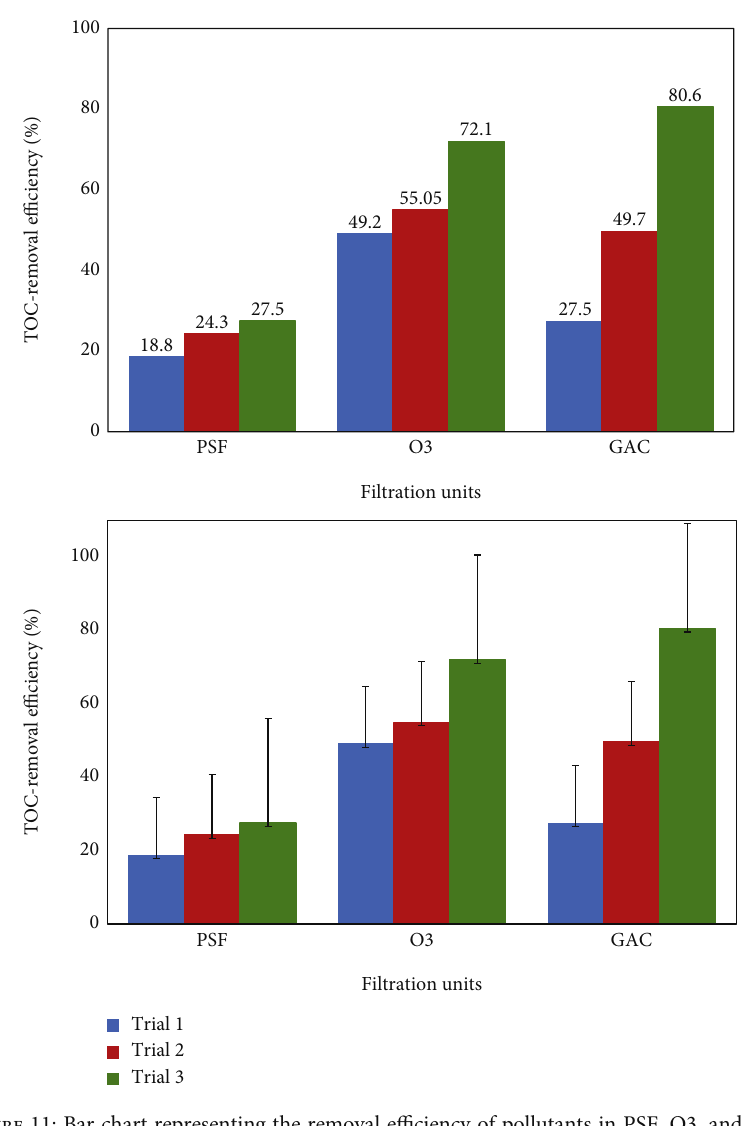
Figure 11: Bar chart representing the removal e ffi ciency of pollutants in PSF, O3, and